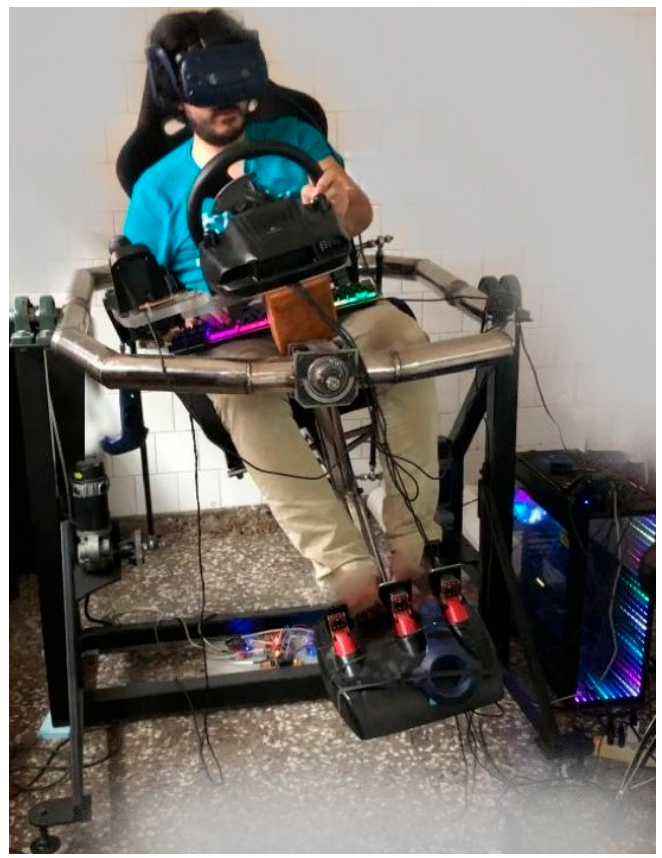
Figure 4. Grid system of IA (physical platform).